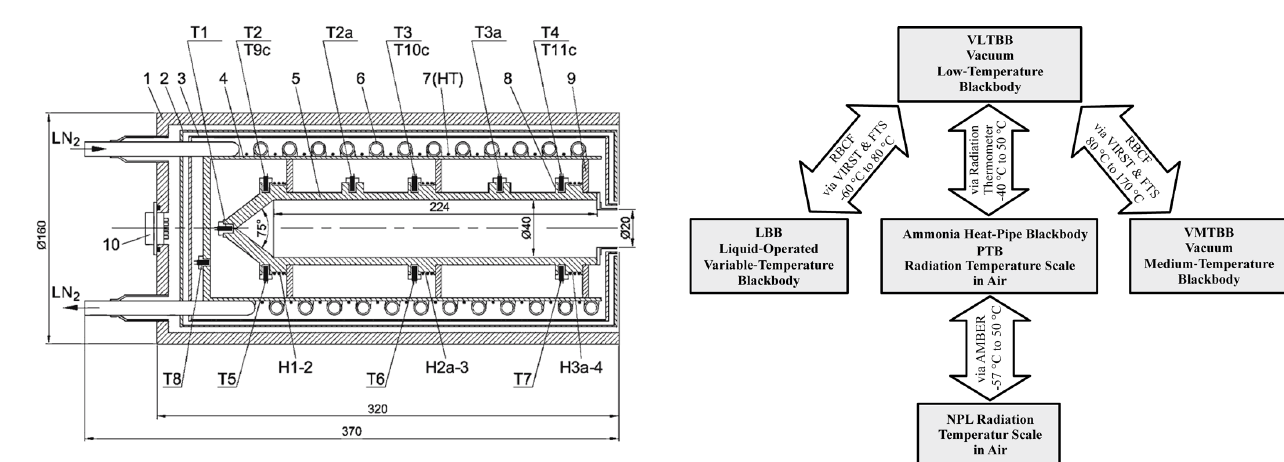
Fig. 8. Schematic diagram of the Vacuum Low Temperature Blackbody: 1 – body of the VLTBB, 2 – second radiation shield, 3 – first radiation shield, 4 – Cryo-shroud, 5 – cavity, 6 – cryo-shroud heat-exchanger, 7 – cryo-shroud heater, 8 – ring-shaped enhancement of the cavity, 9 – heat link, 10 – electrical connector.